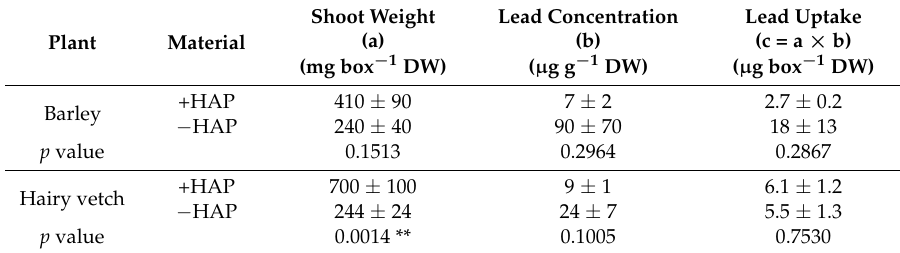
Table 2. Shoot biomass, lead concentration, and amount of lead uptake by plants grown in the rhizobox system ( n =